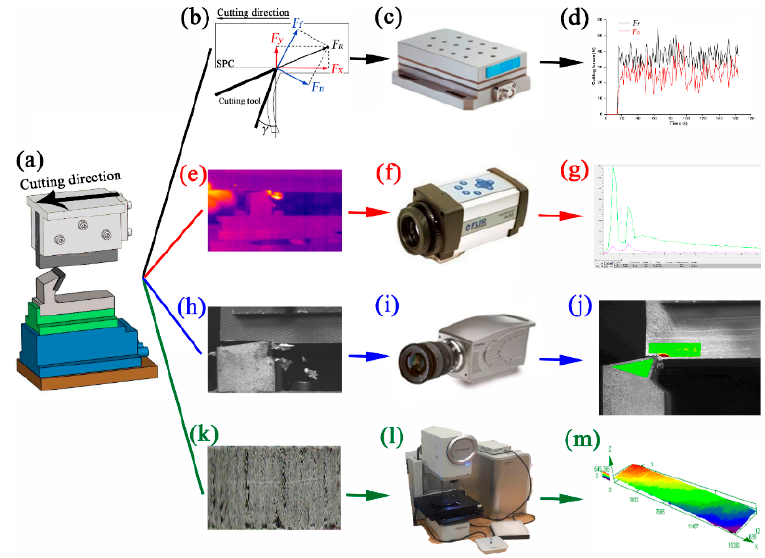
Figure 1. Experimental system: ( a ) Planing, ( b – d ) measurement of forces, ( e – g ) cutting heat, ( h – i ) chip formation, and ( k – m ) machined surface.